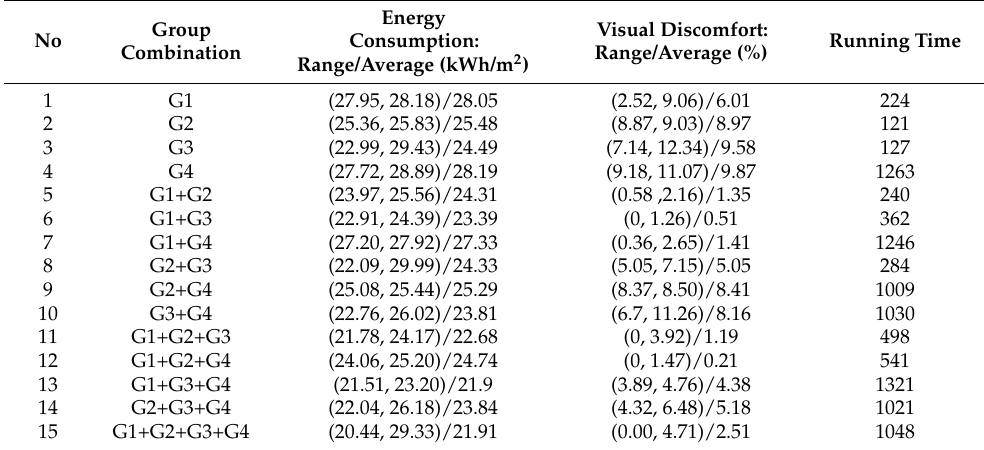
Table 10. Group optimization